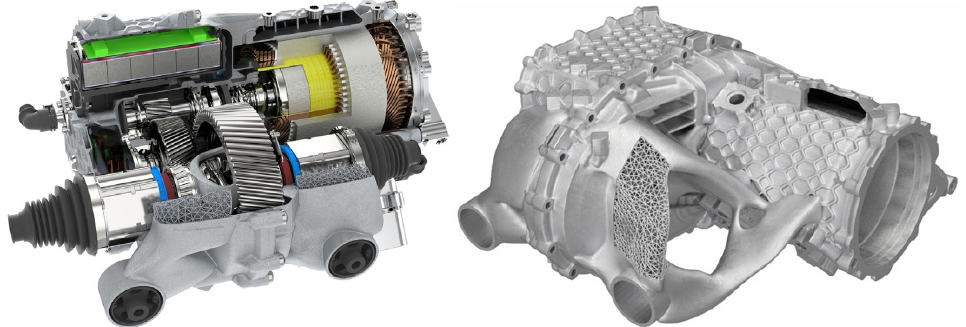
Figure 11. Porsche’s electric traction drive system and its housing realized via AM technology, reproduced with permission from the owner, tuningblog.eu (Germany) [146]. reproduced with permission from the owner, tuningblog.eu (Germany) [146].